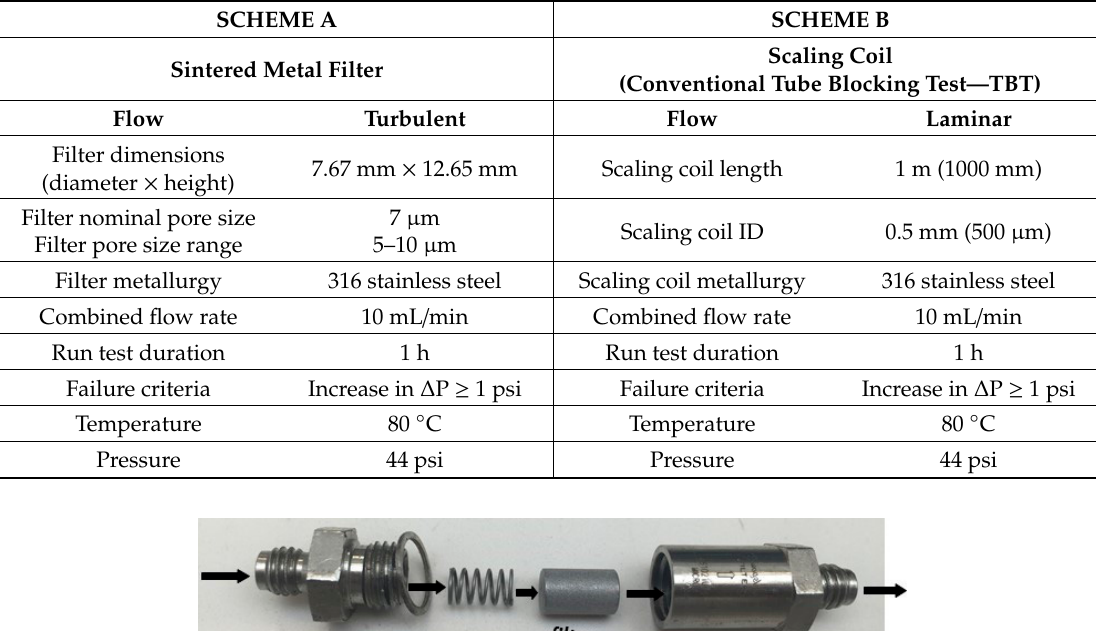
Table 2. Summary of dynamic tests conditions. Figure 2. Schematic of dynamic scale system: Scheme A—using a filter with 7 µm pores and Scheme B—using a scaling coil with 500 µm inner diameter.